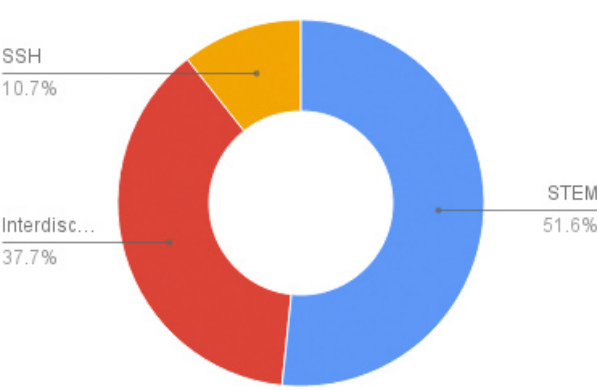
Figure 3. Breakdown of OPR definitions by disciplinary scope.